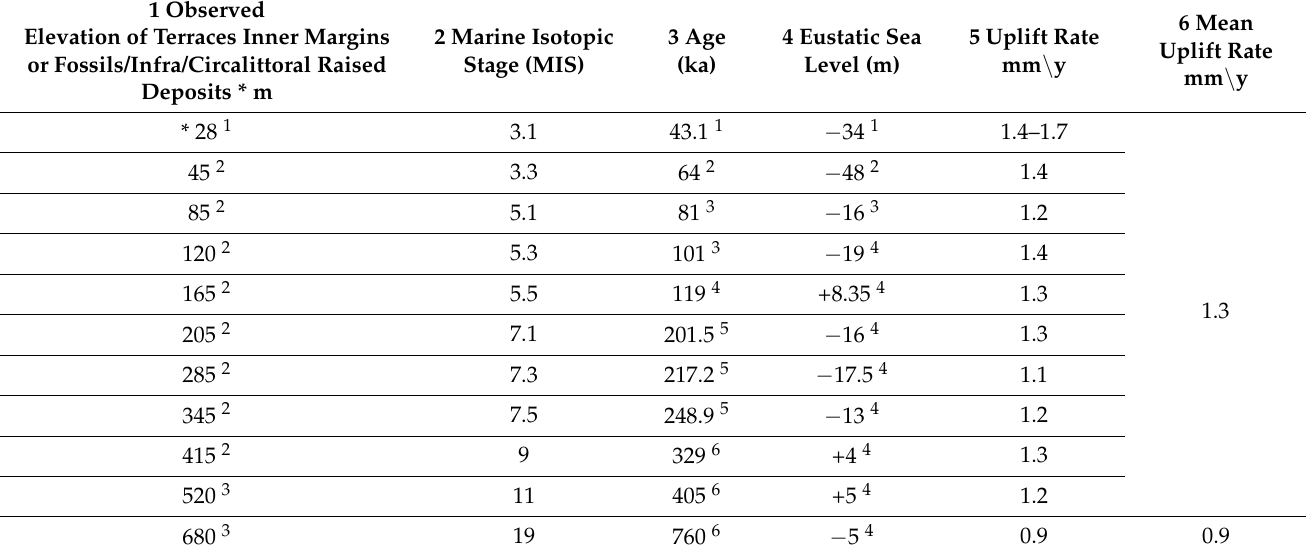
Table 5. ( 1 ) Elevation of sea level markers from: this paper 1 ; Monaco et al. [15] 2 ; and Miyauchi et al. [26] 3 . The distinct inner edges were mapped by these authors with an error margin in the elevation of ± 5 m, depending on the erosion and depositional processes following the emergence of the terraces. An error between 0 and − 10 m was applied for the fossil raised deposits *. This implies that the elevations above sea level of the inner edges must be considered as mean